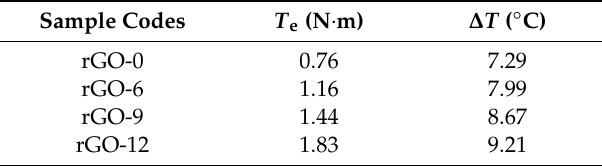
Table 2. Torque rheological parameters: the equilibrium torque ( T e ) and the shear heat ( ∆ T ) of the redox graphene nanoplatelet (rGO) / polylactic acid (PLA) composites with di ff erent rGO